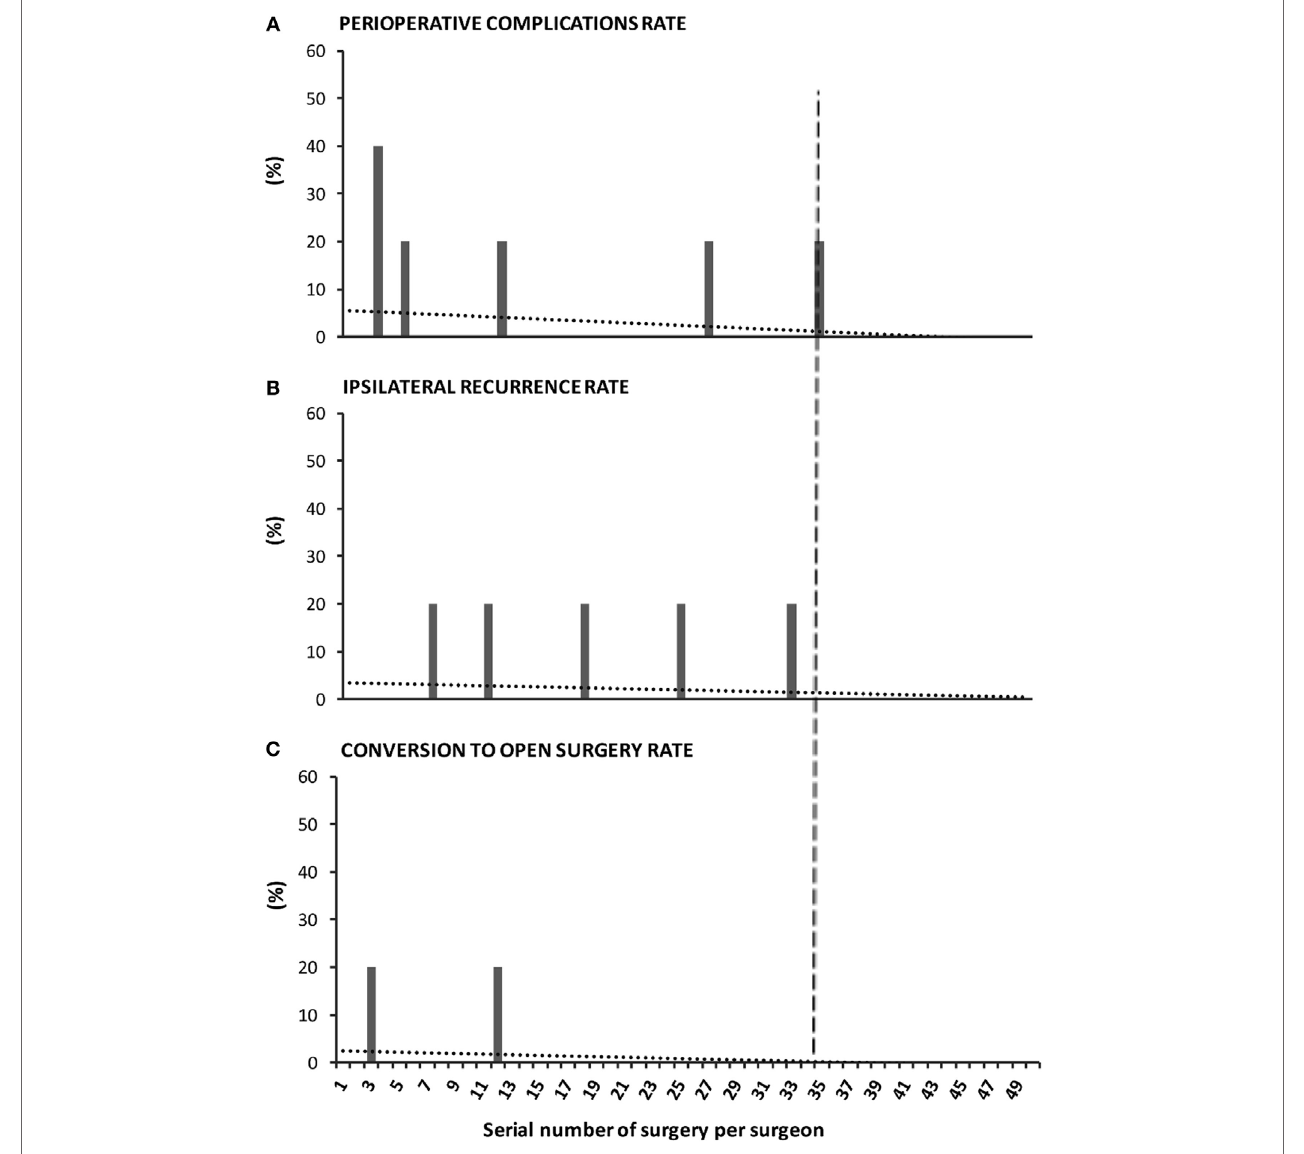
FigUre 5 | Surgeon-centered analysis of the learning curve of percutaneous internal ring suturing (PIRS) technique. The graph reflects the cumulative experience of five staff surgeons throughout their first 50 surgeries by PIRS. The performance was evaluated by the (a) rate of perioperative complications, (B) rate of ipsilateral recurrence, and (c) rate of conversion to open surgery. The dotted lines represent the tendency lines. The dashed vertical line crossing the x -axis at point 35 marks the end of the learning curve, as no events occur after the 35th case of each